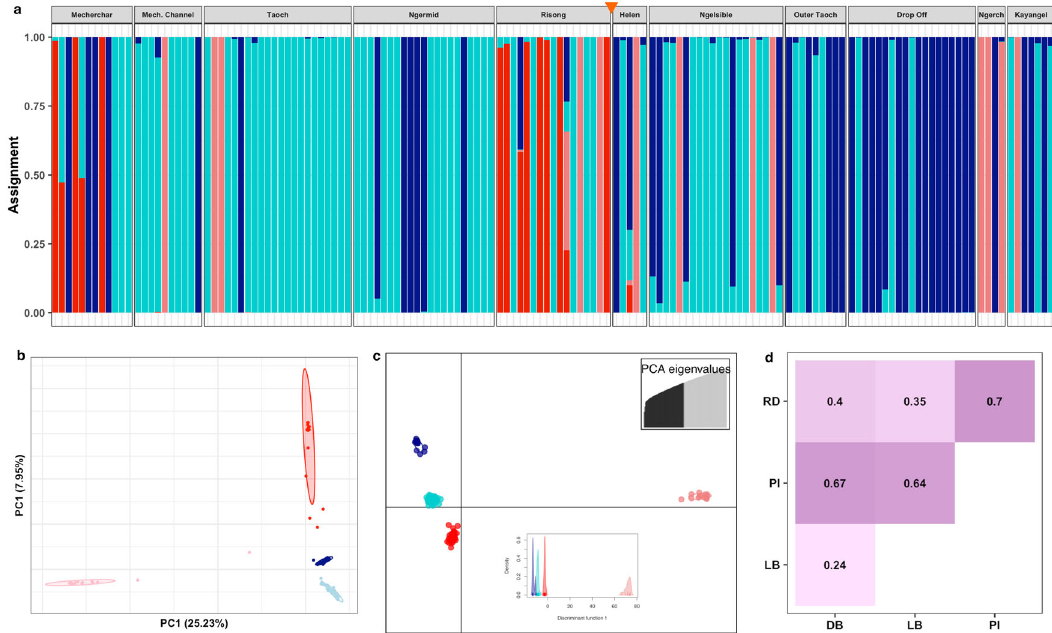
Fig. 3 RAD-seq based population structure of Porites cf. lobata . a STRUCTURE for K = 4. Rock Island sites are shown fi rst (left of orange triangle), followed by outer reef sites (right of triangle). RI sites are dominated by light blue (LB) and red lineages (RD) while the dark blue (DB) and pink lineages (PI) are more common on the outer reefs. b Principal component analyses of RAD-seq data. Points represent individual samples and are colored by their dominant lineage (>50% assigned lineage based on STRUCTURE results). c Discriminant analysis of principal components (DAPC) recapitulates the four lineage clusters. Points are individual samples, colored by their dominant lineage assignment. Top inset shows number of retained principal components for analysis (70) based on cross-validation optimization. Lower inset shows density across the fi rst discriminant axis. d Pairwise Nei ’ s F ST values between lineages. Background color intensity increases with higher F ST